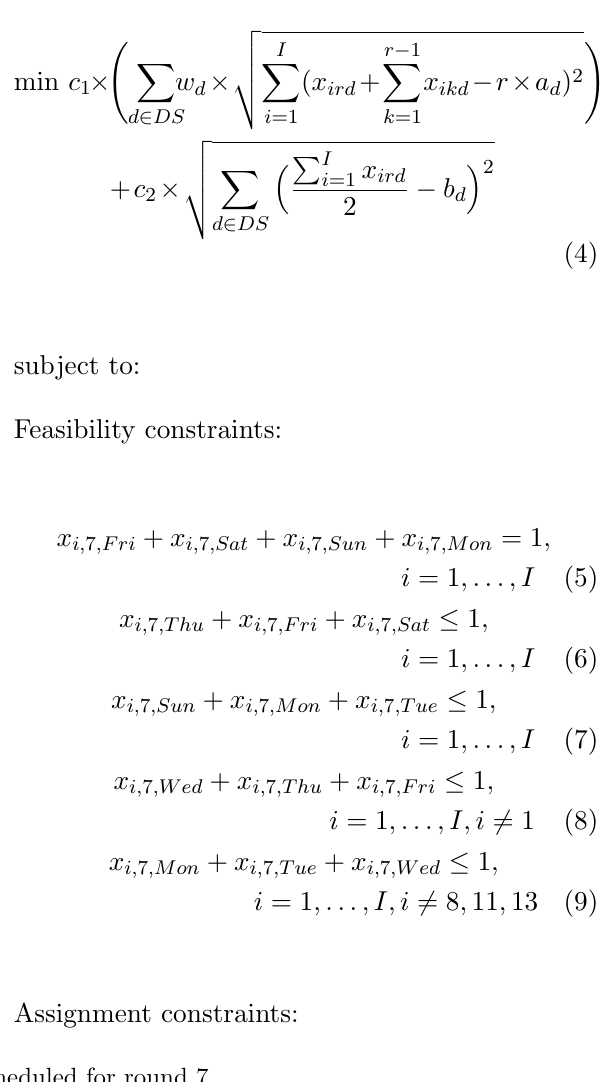
Table 3. Games scheduled for round